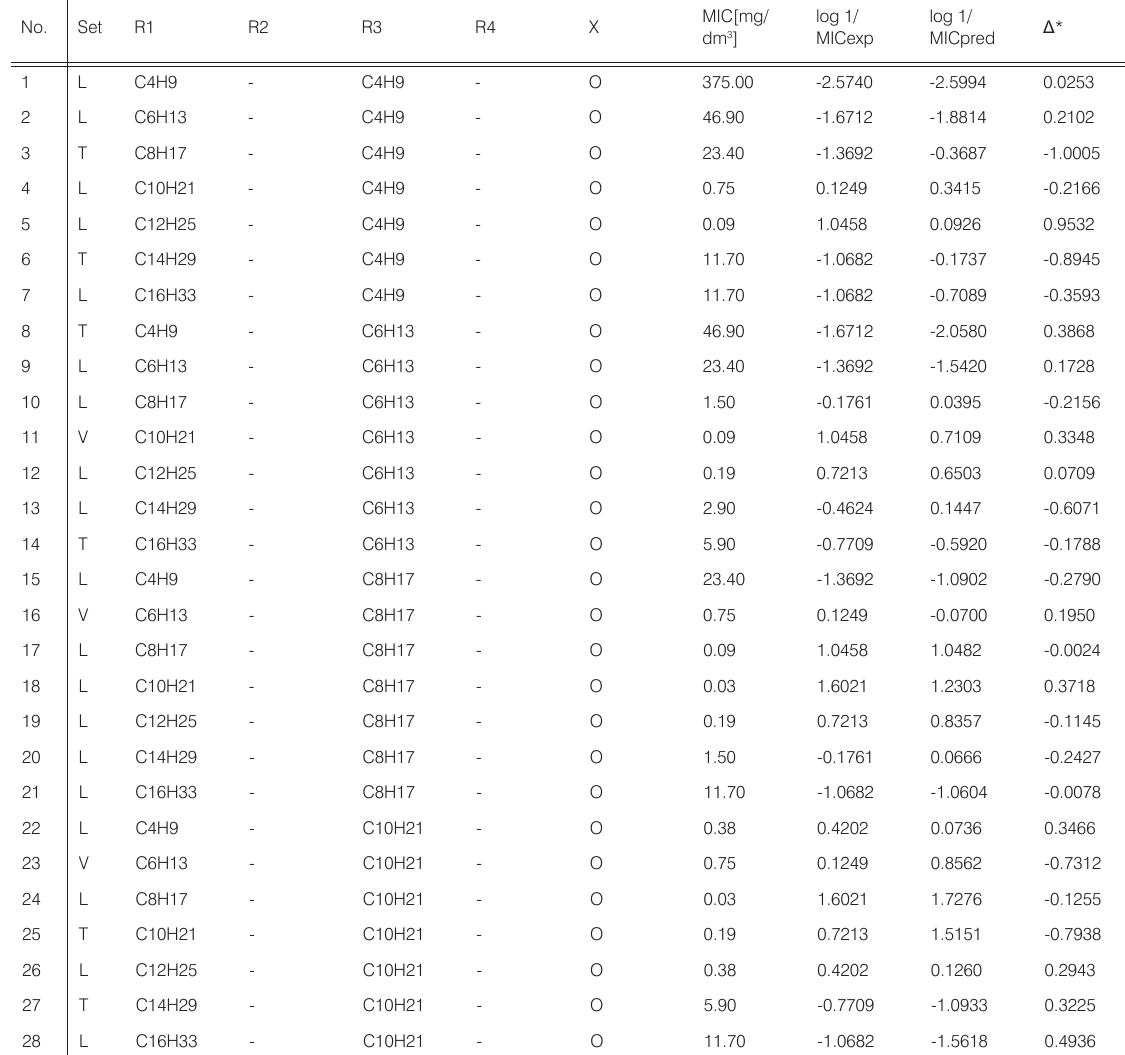
Table 1S. Experimental and predicted logarithms of reciprocal of the minimal inhibitory concentrations, log 1/MIC along with the errors between those two